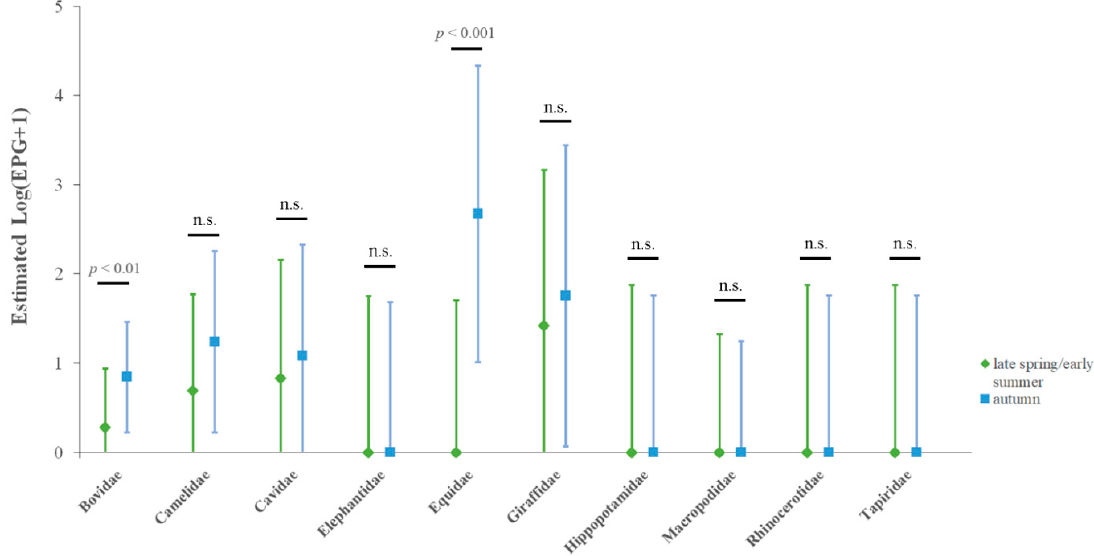
Figure 2. Estimated nematode Log(EPG+1) by host family and time of sampling in herbivores housed in the studied faunistic park, obtained by a generalized linear mixed model. Vertical bars: 95% confidence intervals; horizontal black bar: significant pairwise comparison between nematode eggs excretion in the two samplings by family; n.s.: not